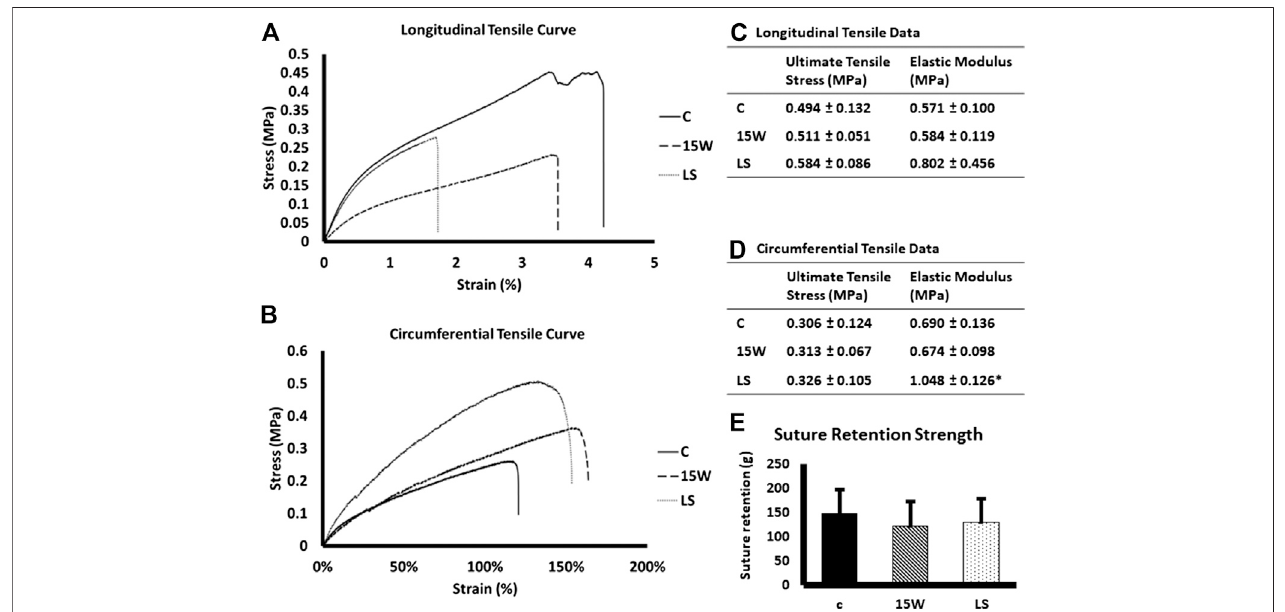
FIGURE 9| Additional bulk mechanical propertiesof the selected groups. (A) Longitudinal tensile curve. (B) Circumferential tensile curve. (C) Longitudinal ultimate tensile strength and elastic modulus for each groups. (D) Circumferential ultimate tensile stress and elastic modulus. (E) Suture retention strength. n (cid:2) 6 for tensile test results, and n (cid:2) 9 for suture retention strength for all groups. *Indicates p ＜ 0.05 with respect to the control group.